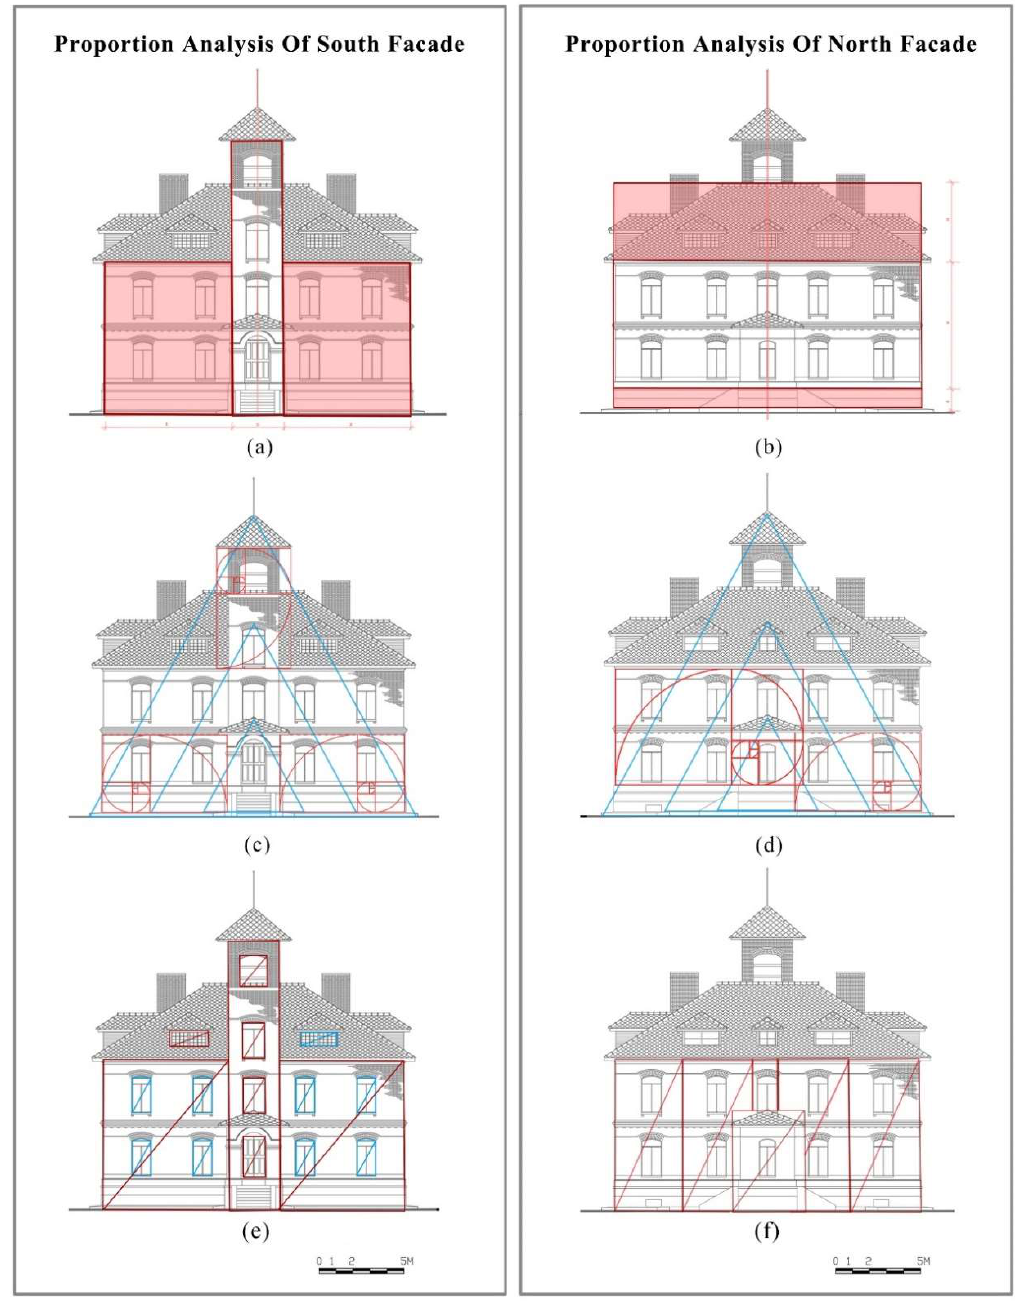
Figure 9. Proportion analysis (source: author). ( a ) The three-fold division of the south facade ( b ) The tripartite division of the north facade ( c ) The golden section and similar triangles of the south facade ( d ) The golden section and similar triangles of the north facade ( e ) The similar rectangular of the south facade ( f ) The similar rectangular of the north facade.